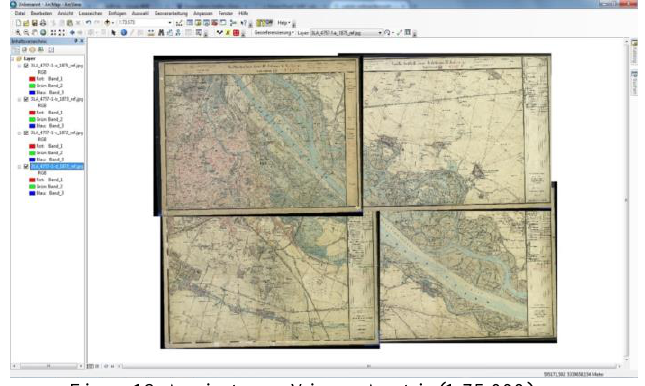
Figure 12. Ancient map, Vienna, Austria